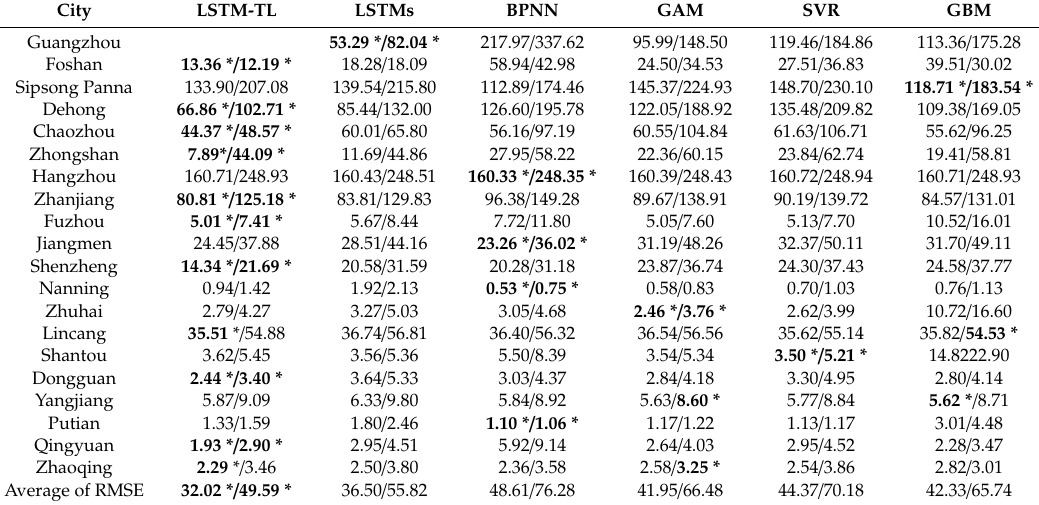
Table 3. Comparison of model performances using the root mean square error (RMSE). The number before the symbol “ / ” is the RMSE of the model prediction for the last 24 months, and the number after the symbol “ / ” is the RMSE of the model prediction in the outbreak period (July to November in 2017 and 2018). TL: Transfer